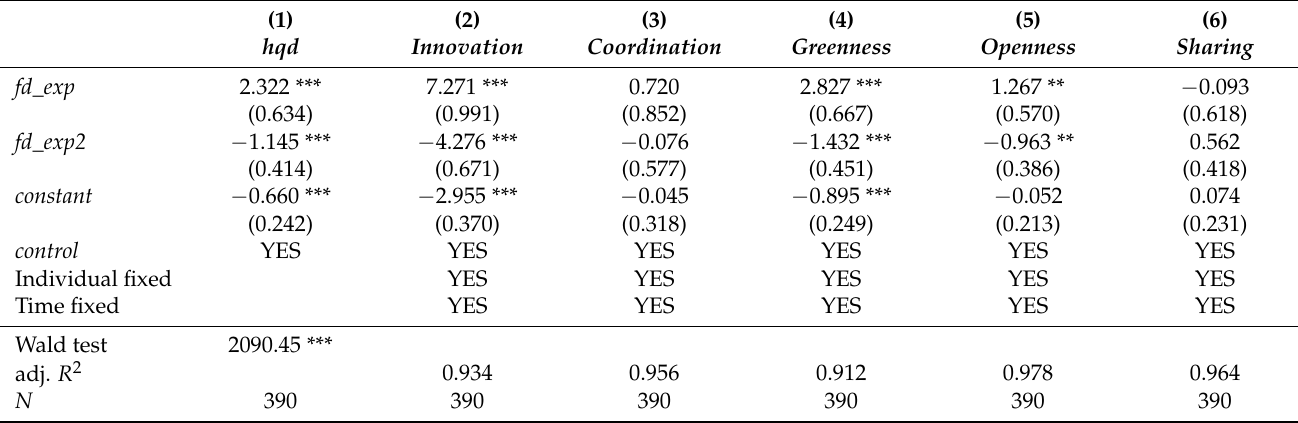
Table 5. The robustness